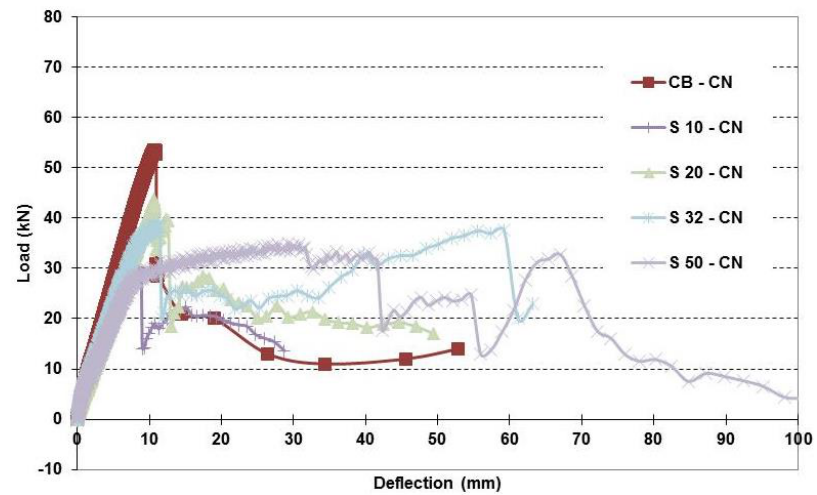
Figure 8. Load-deflection relationships of control beam and beams with simulated corrosion.